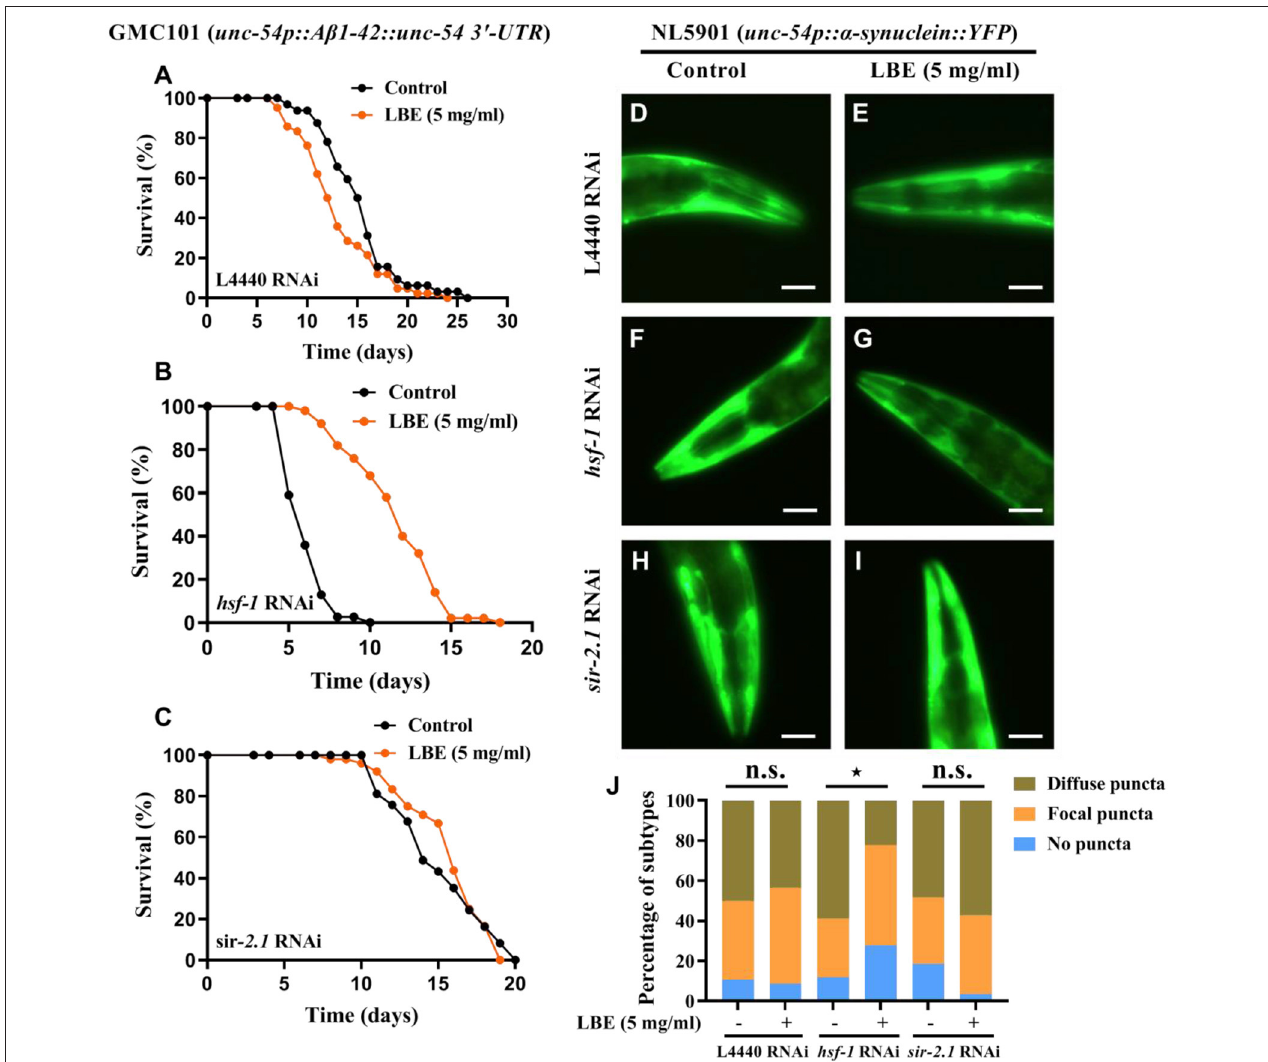
FIGURE 7 | LBE extends lifespan and alleviates toxic protein aggregation in neurodegenerative worms with hsf-1 deficiency. (A) Lifespan analysis of GMC101 ( unc-54p::A β 1-42::unc-54 3’-UTR ) worms fed with empty vector L4440 RNAi bacteria treated with vehicle or 5 mg/ml LBE at 20 ◦ C (control: n = 32, mean lifespan 15.3 days; 5 mg/ml LBE: n = 42, mean lifespan 13.0 days; p = 0.051). (B) Lifespan analysis of GMC101 worms fed with hsf-1 RNAi bacteria treated with vehicle or 5 mg/ml LBE at 20 ◦ C (control: n = 39, mean lifespan 6.1 days; 5 mg/ml LBE: n = 50, mean lifespan 11.7 days; p < 0.0001). (C) Lifespan analysis of GMC101 worms fed with sir-2.1 RNAi bacteria treated with vehicle or 5 mg/ml LBE at 20 ◦ C (control: n = 37, mean lifespan 15.0 days; 5 mg/ml LBE: n = 48, mean lifespan 15.6 days; p = 0.715). (D–I) Graphical representations for epifluorescence visualization of α -synuclein aggregation in anterior region of NL5901 ( unc-54p:: α -synuclein::YFP ) worms at day 3 ( ∼ 20 worms per condition). (D,E) , NL5901 fed with empty vector L4440 RNAi bacteria in the absence or presence of 5 mg/ml LBE. (F,G) , NL5901 fed with hsf-1 RNAi bacteria in the absence or presence of 5 mg/ml LBE. (H,I) , NL5901 fed with sir-2.1 RNAi bacteria in the absence or presence of 5 mg/ml LBE. Scale bar, 50 µ m. (J) Bar chart of classification (no puncta, focal puncta, or diffuse puncta according to the degree of α -synuclein aggregation on fluorescent graphs) composition for per condition. All the results are representative of at least two independent experiments. Log-rank test [for (A–C) ] or Mann–Whitney U test [for (J) ] was used to assess significance. n.s., not significant difference, ⋆ P < 0.05 (see also Supplementary Table 7 ). LBE, total water extracts of L. barbarum